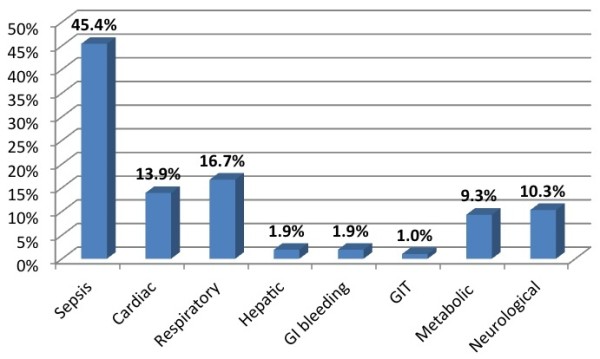
Frequency of primary clinical diagnoses of patients.